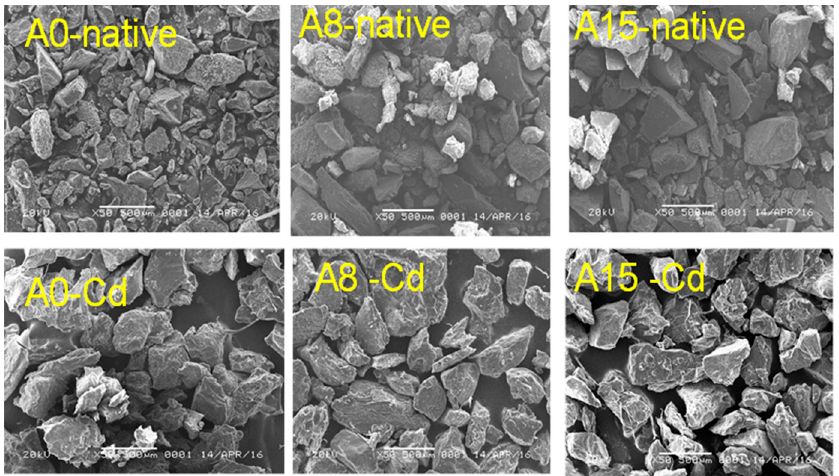
Figure 2. SEM images of three types of dried biosorbent Aphanothece sp. before and after sorption of Cd 2+ at a magnification of 50×.